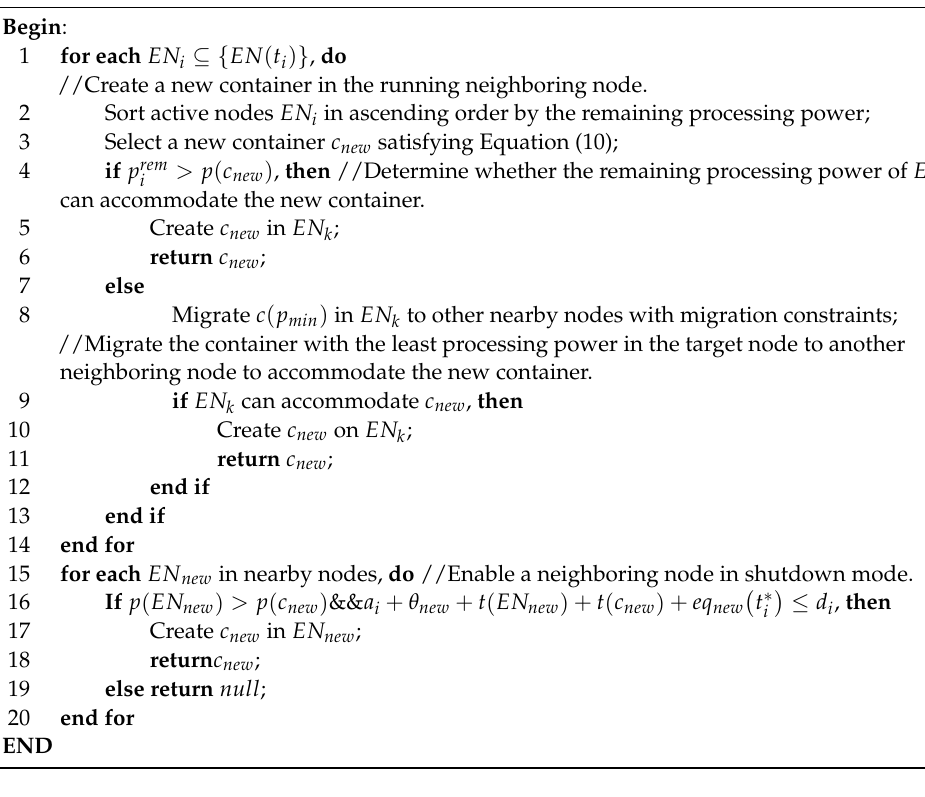
Algorithm 3. Container resource-adaptive adjustment algorithm resAdapt ()